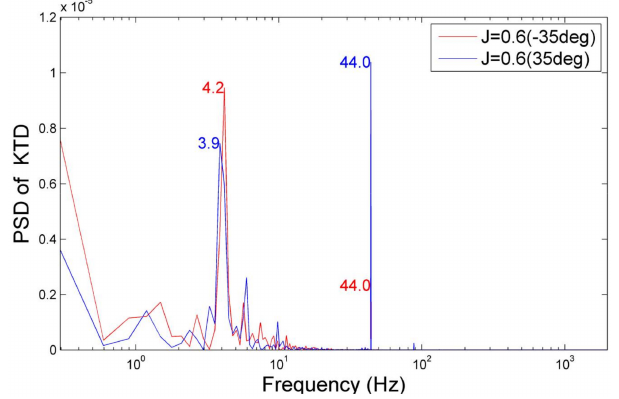
Figure 13. Power spectral density of duct thrust, KTD, at J = 0.6, for the positive and negative heading angles of 35 degrees.